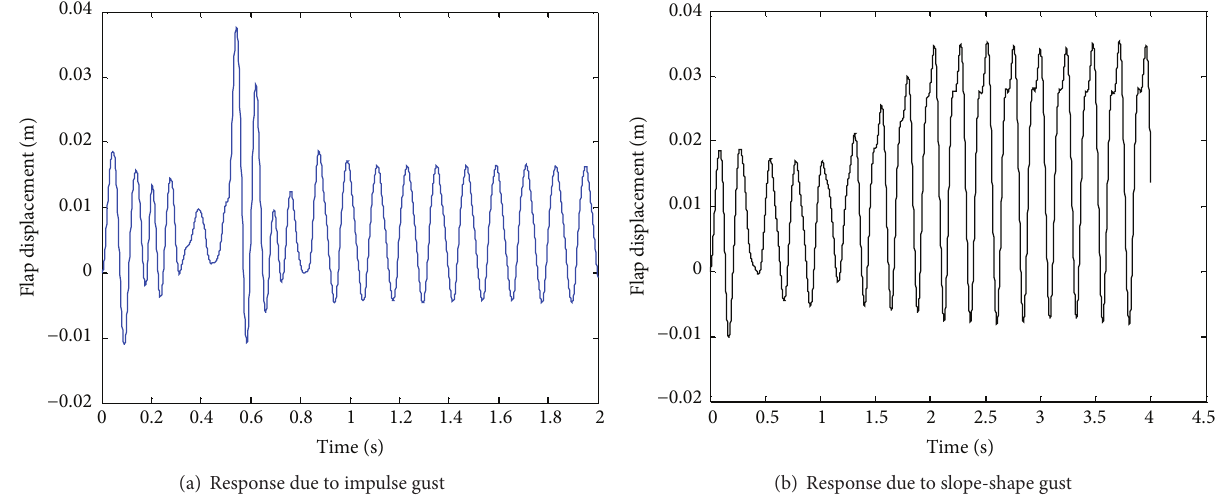
Figure 10: Time response of flap displacement at the tip.